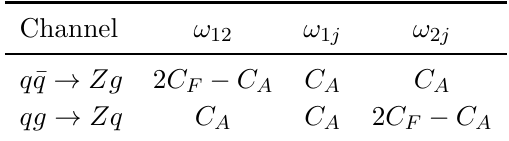
Table 2 . Colour coefficients ω C ≡ ( − 2 T a · T b ) for different flavour channels in Z + jet events. ab